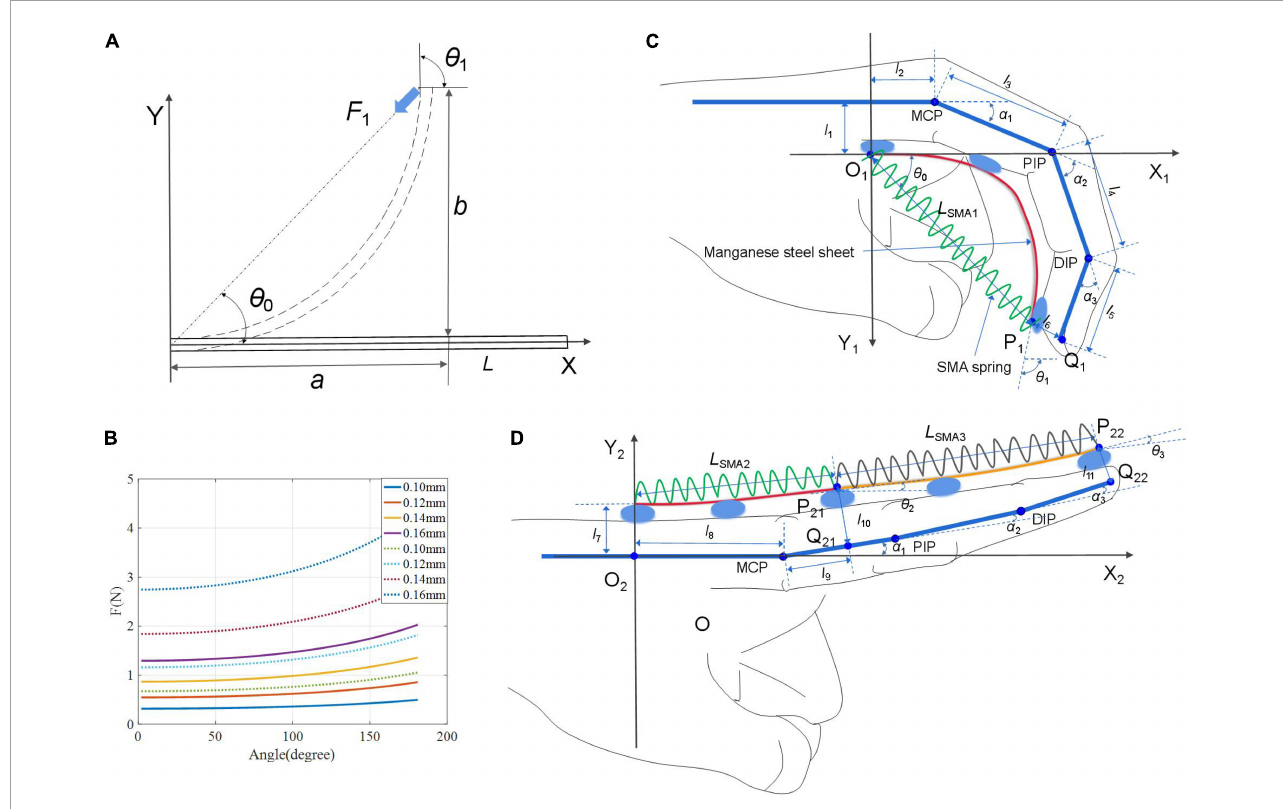
FIGURE7 Human-exoskeleton coupling model. (A) Force model of manganese steel sheet; (B) the variation curve of F 1 with the angle at different thicknesses; (C,D) the human-exoskeleton coupling model of finger flexion and